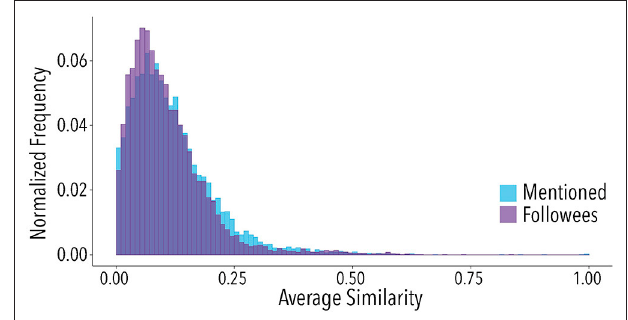
FIGURE 3 | Distribution of average similarity between central users and their followees (blue) and between central users and randomly selected groups of the same size (purple). KS(Kolmogorov-Smirnov statistic) = 0.37, p < 0.001, MW(Mann-Whitney U effect size) = 0.75, p < 0.001 The medians of the distributions of Followees and the Random are 0.087 and 0.041, respectively. Distributions have been calculated considering the whole set of 9,490 central users.